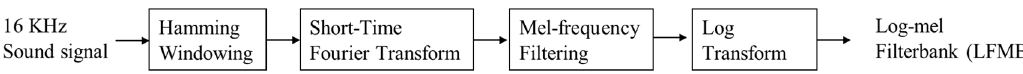
Figure 1. Extraction process of log-mel filterbank (LMFB).